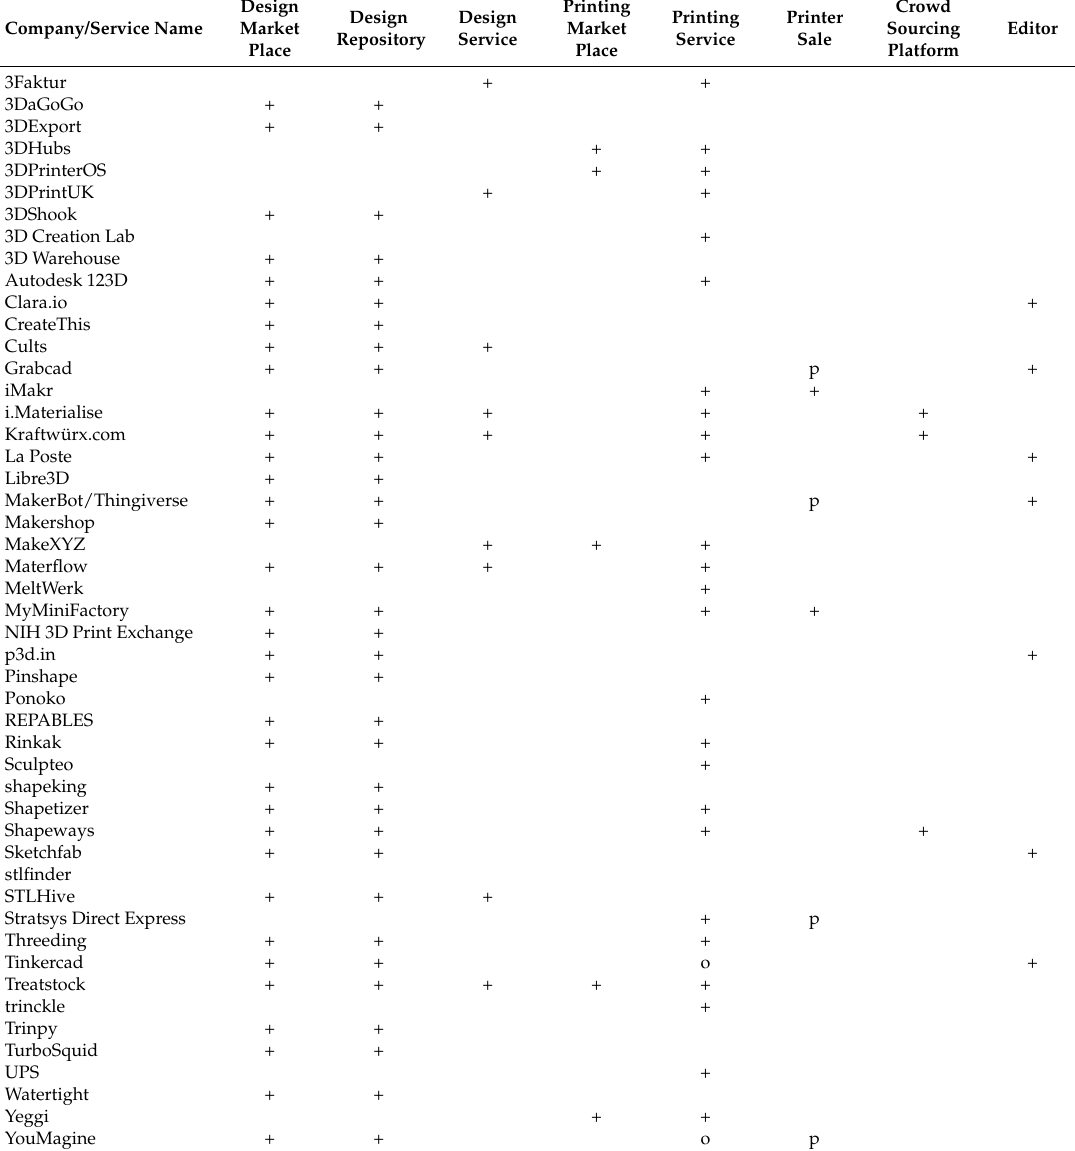
Table 5. Categorising 3D printing online